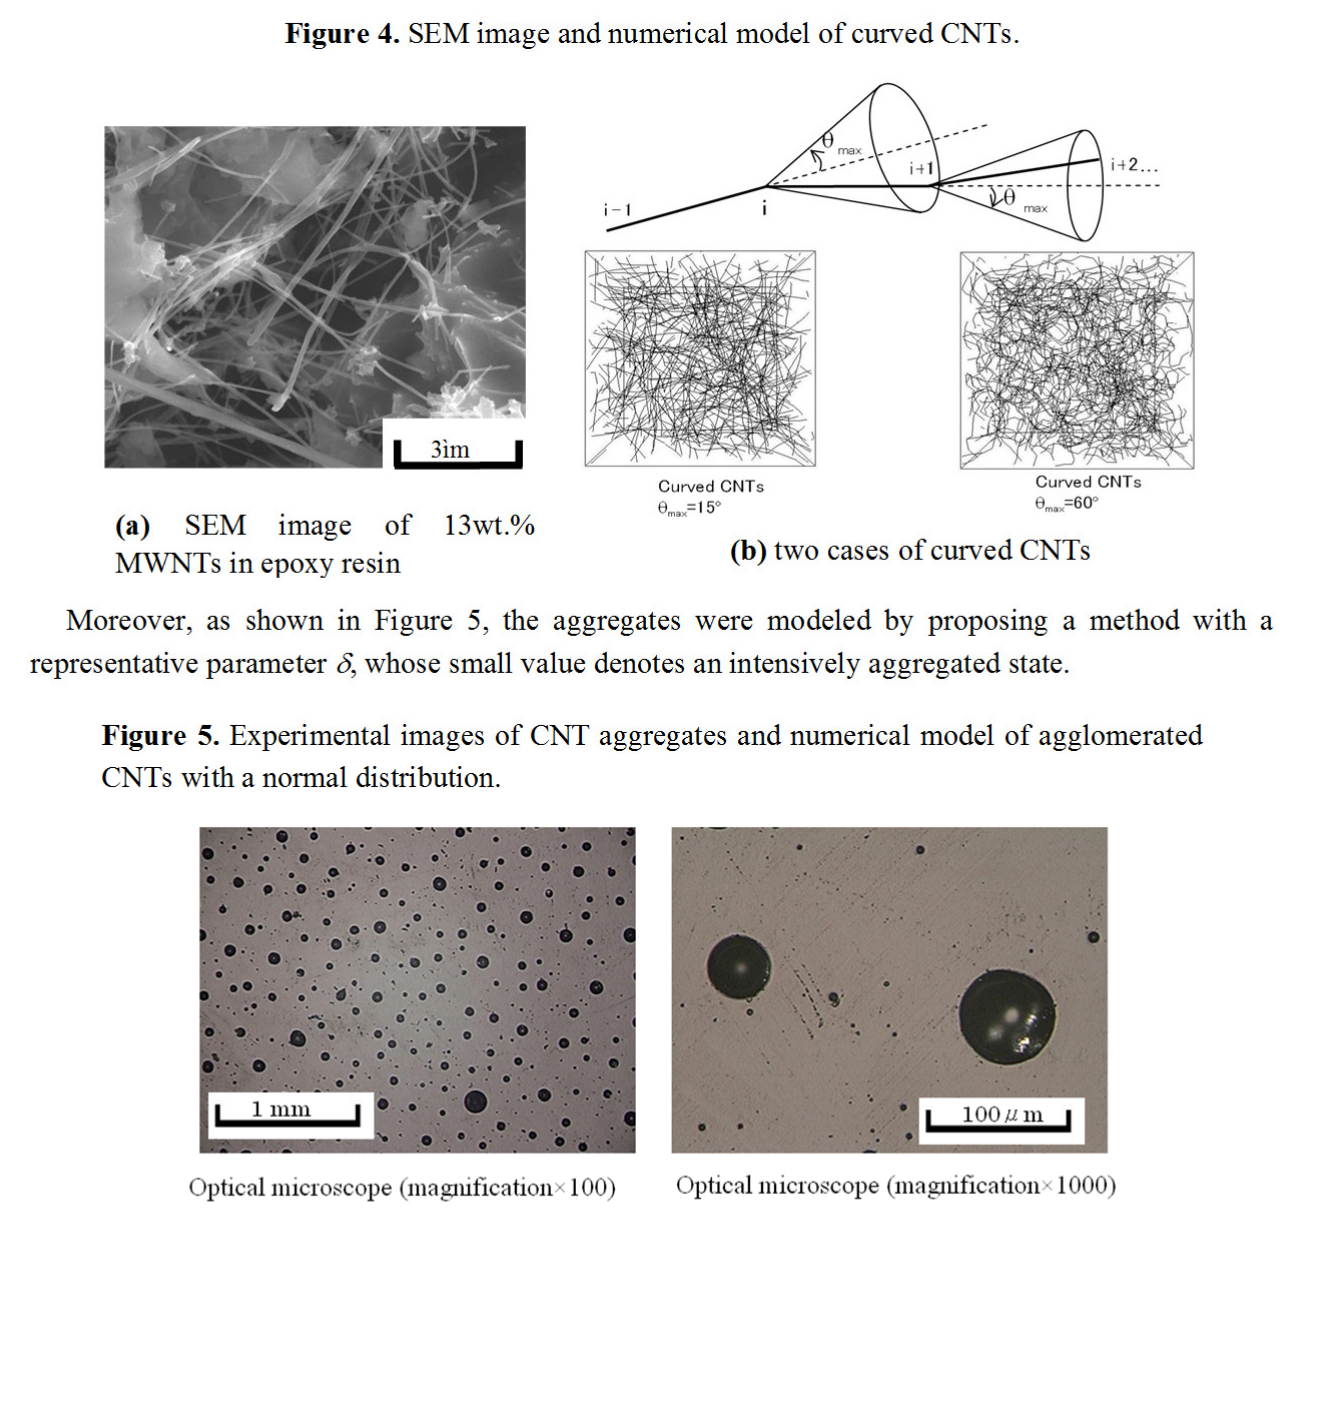
Figure 4. SEM image and numerical model of curved CNTs.